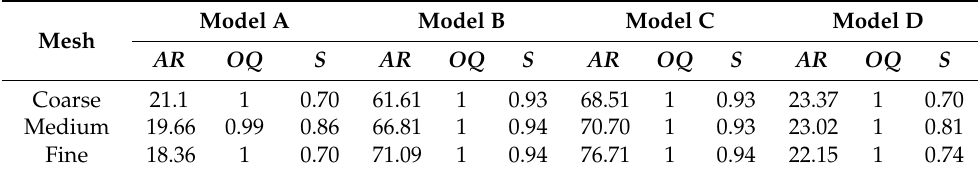
Table 2. Mesh quality parameters of cyclone models A, B, C and D.